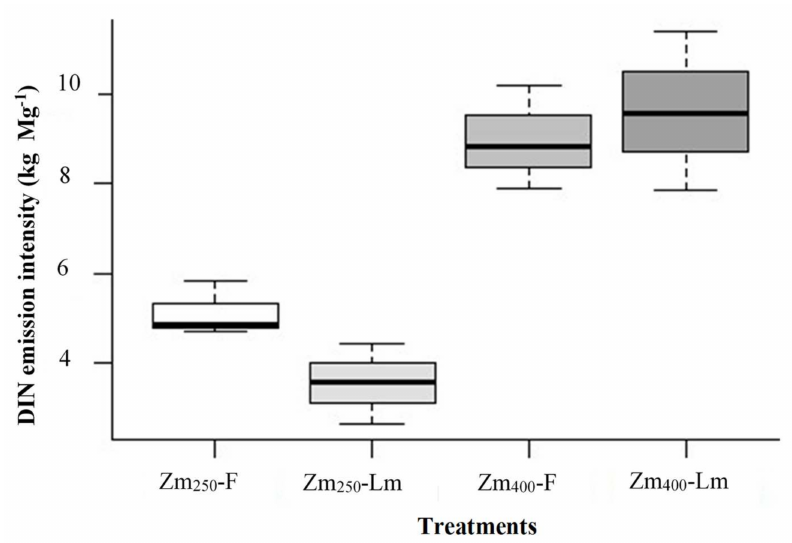
Figure 7. Dissolved inorganic nitrogen emission intensity (kg ha − 1 ) for each Mg of grain produced at the end of the maize growing